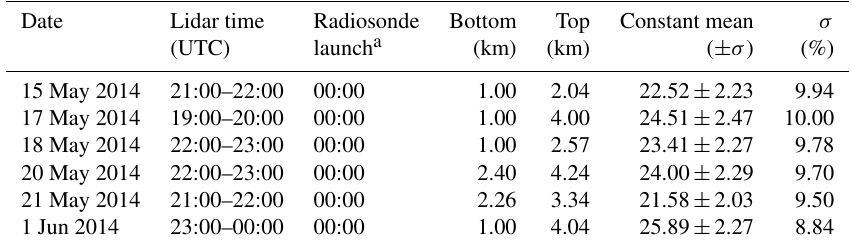
Table 1. Calibration constant mean values for each case of high-resolution radiosounding.